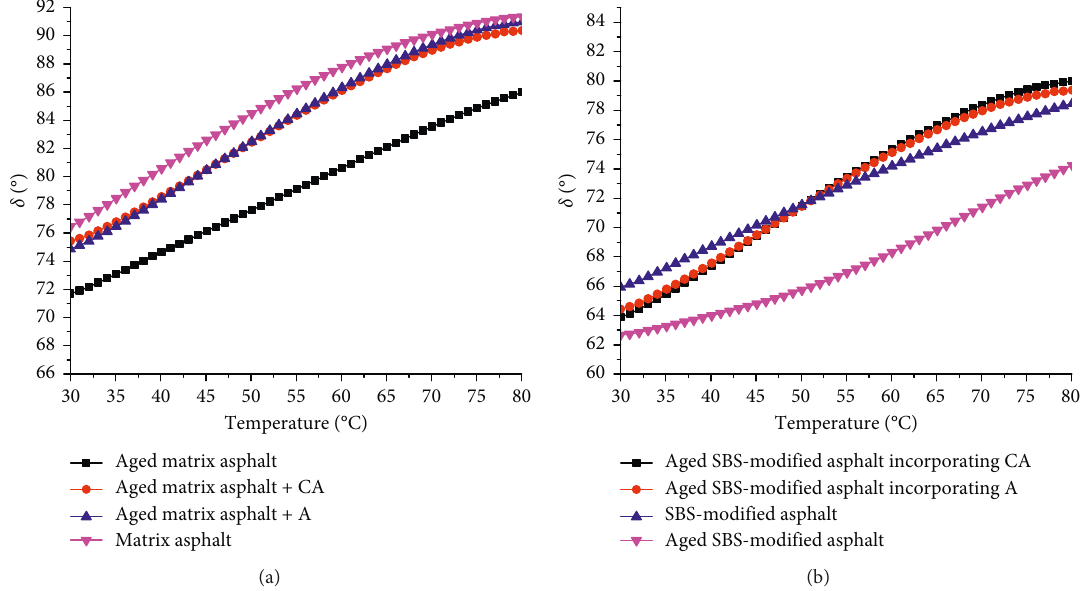
Figure 9: δ curves of asphalt at different temperatures: (a) matrix asphalt and (b) SBS-modified asphalt before and after